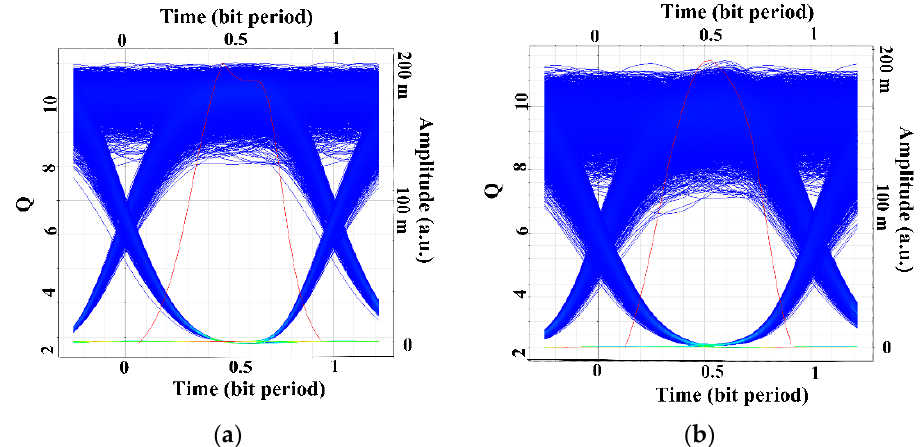
Figure 10. The upstream receiver eye diagram at ( a ) B2B; ( b ) 50 km MMF transmission distance.